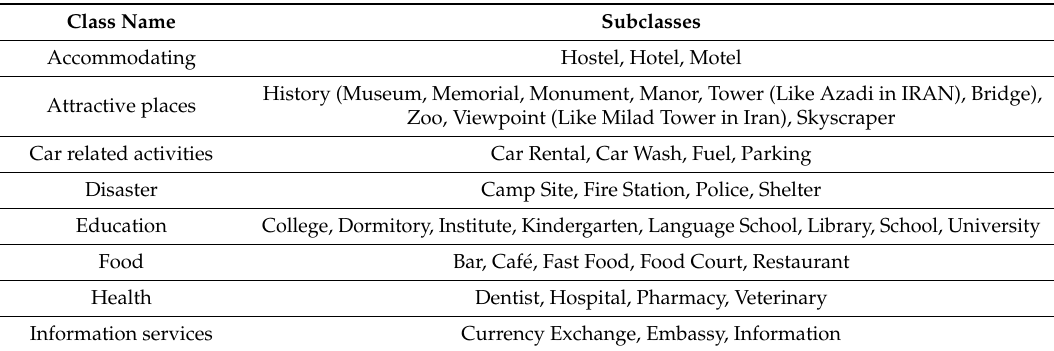
Table 1. Service ontology classes and subclasses.